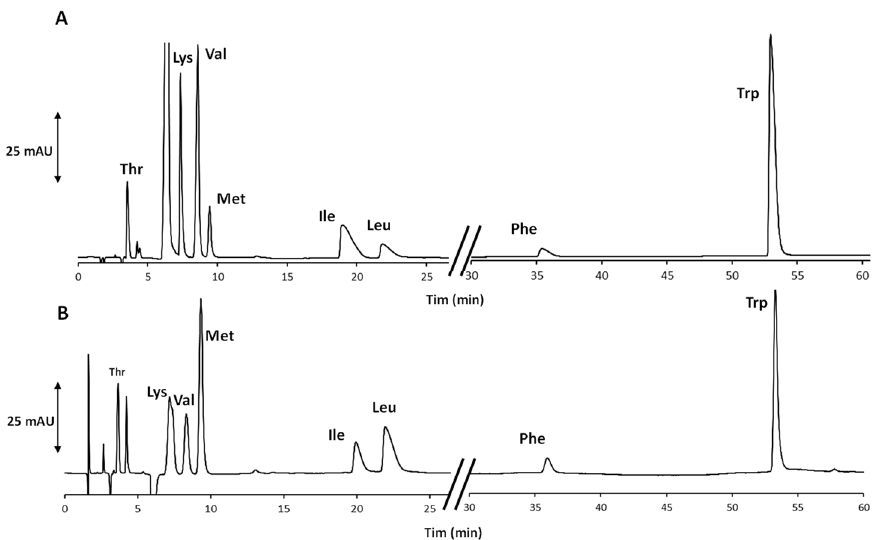
Figure 1. Chromatograms of ( A ) the mixture of eight AA standards and ( B ) the extract from the selected food supplements. The chromatographic conditions correspond to those labelled as “f” in the footnote to Table 1.